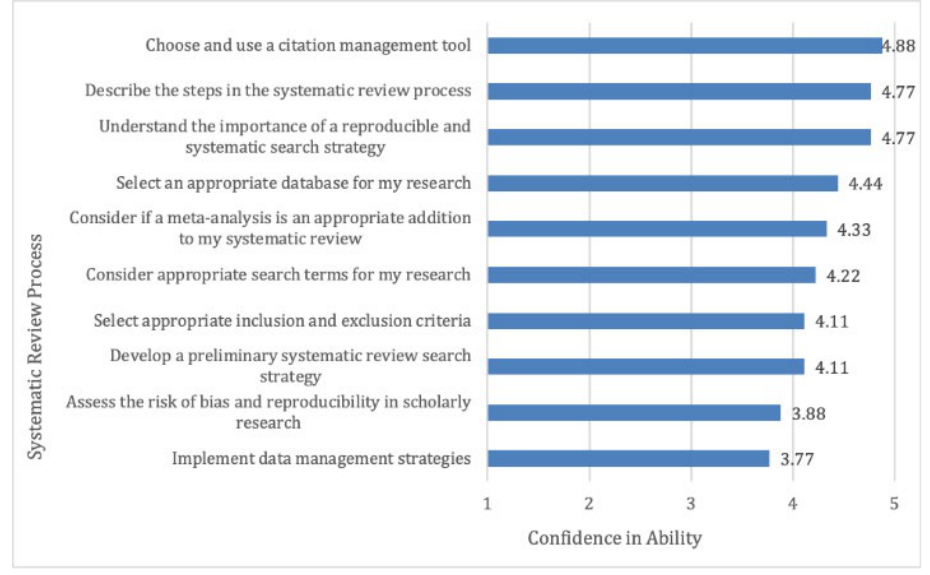
Figure 2 Post-assessment survey results: Student self-reported confidence in systematic review processes at course